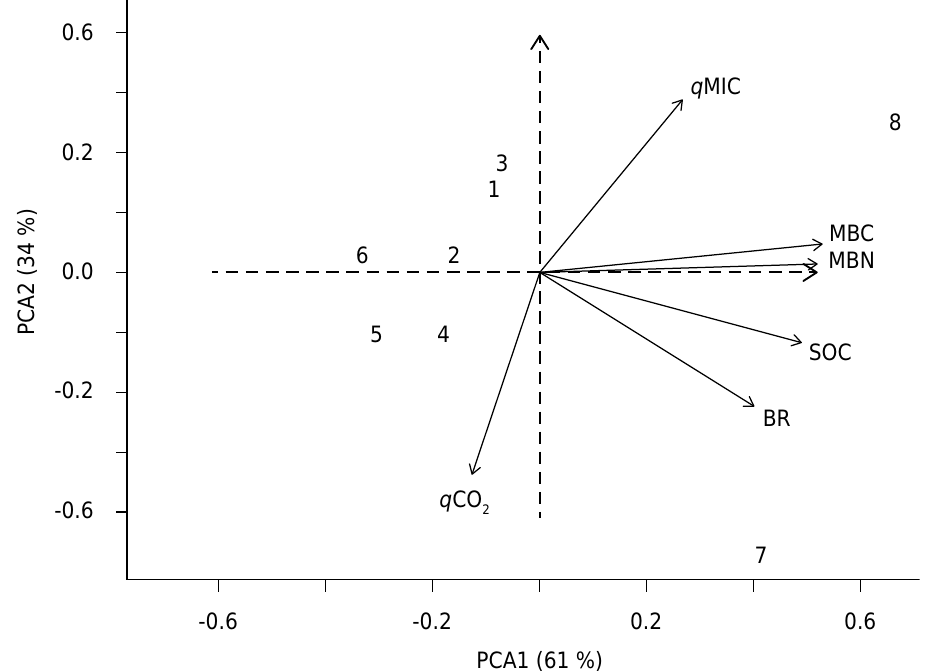
Figure 3. Biplot generated by principal component analysis (PCA) of the biological properties in the 0.00-0.10 m soil layer of the Latossolo Vermelho Á crico (Oxisol) under different uses in Cachoeira Dourada, MT, Brazil. 1, 2, 3, 4, 5, and 6: sampling in the center row and at 1.5, 3.0, 4.5, 6.0, and 9.0 m from this row, respectively; 7: recovered pasture; and 8: degraded pasture. MBC: microbial biomass carbon, MBN: microbial biomass nitrogen, BR: soil basal respiration, q CO 2 : metabolic quotient, SOC: soil organic carbon, and q MIC: microbial